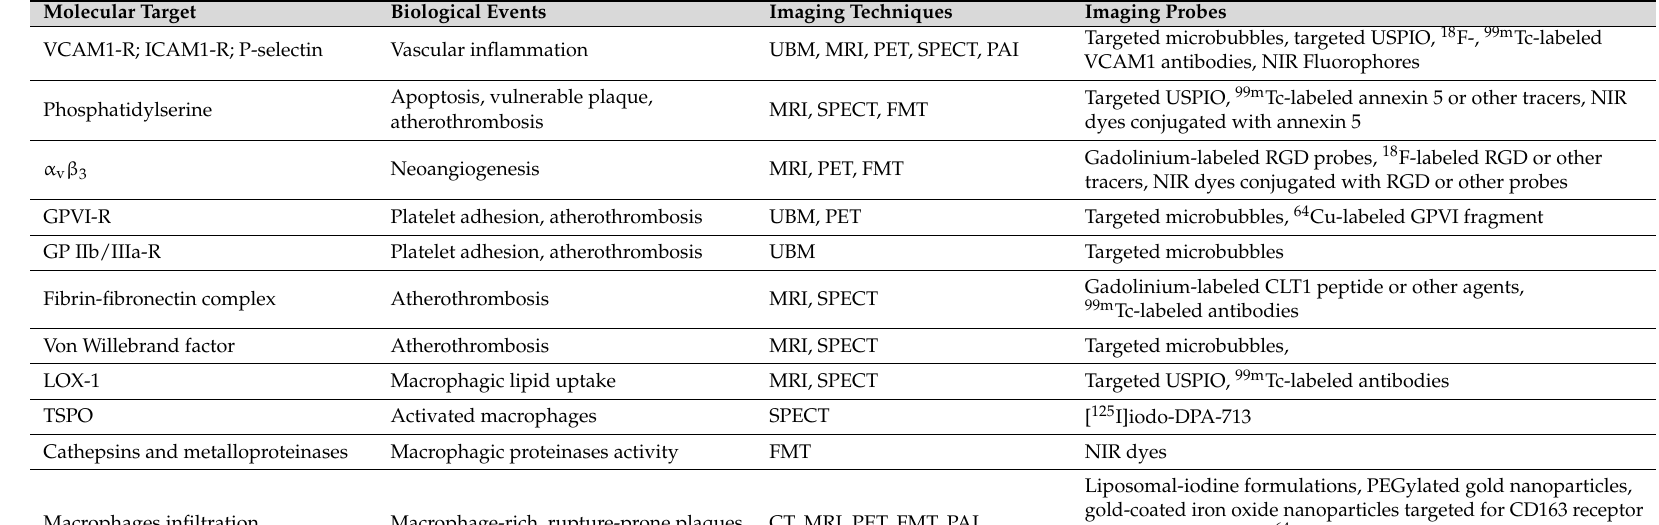
Table 3. Summary of the major targets for molecular imaging of atherosclerosis recently evaluated in mouse models with features of